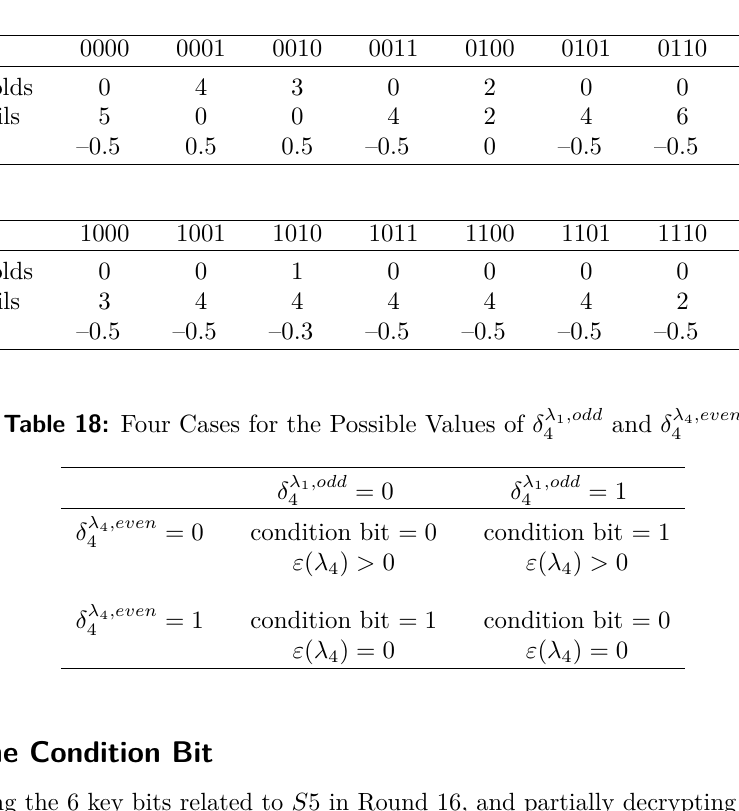
Table 17: Conditioning ε ( λ 1 ) on Each of the 16 Values of the LSB of the Output and the Three Selected Input Bits of S 5